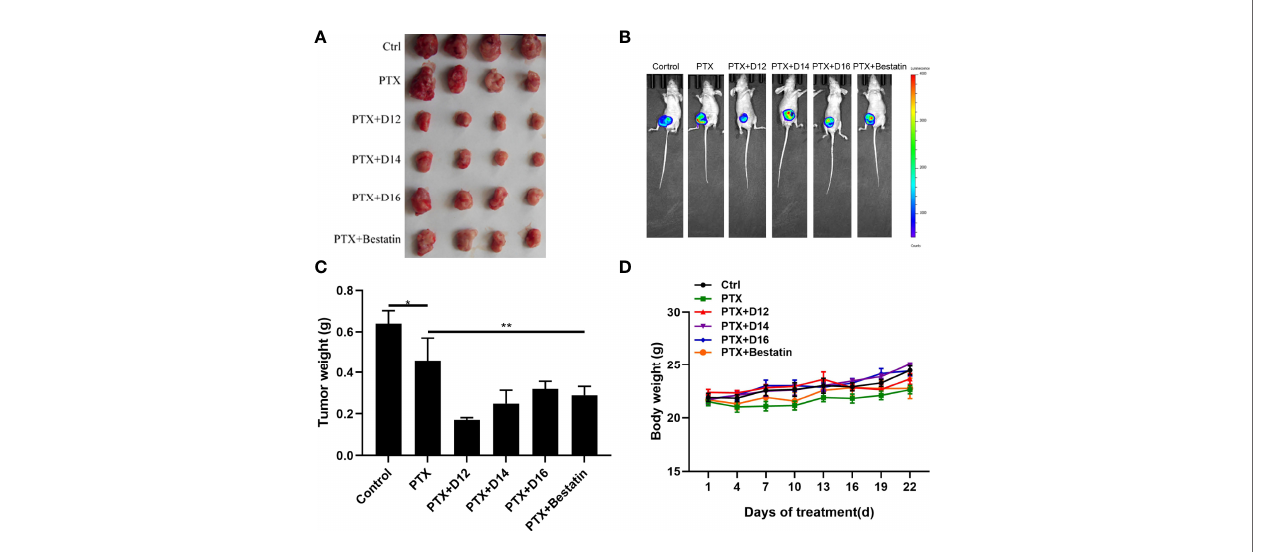
FIGURE 5 | In vivo anticancer effects of the PTX-APN inhibitor combinations. (A) Dissected tumor tissues taken from mice after administration of various drug combinations; (B) representative in vivo imaging of tumors; (C) Tumor weight plot of different administration groups; (D) mice body weight plot of different administration groups; Data were taken as mean ± SEM (n = 4), *P ≤ 0.05, **P ≤